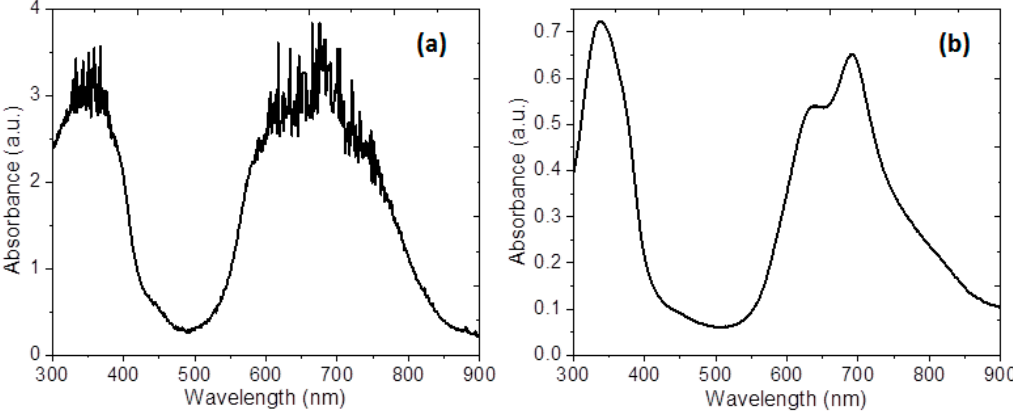
Figure 7. Absorption spectra in the range of 900–300 nm for ( a ) membrane and ( b ) semiconductor